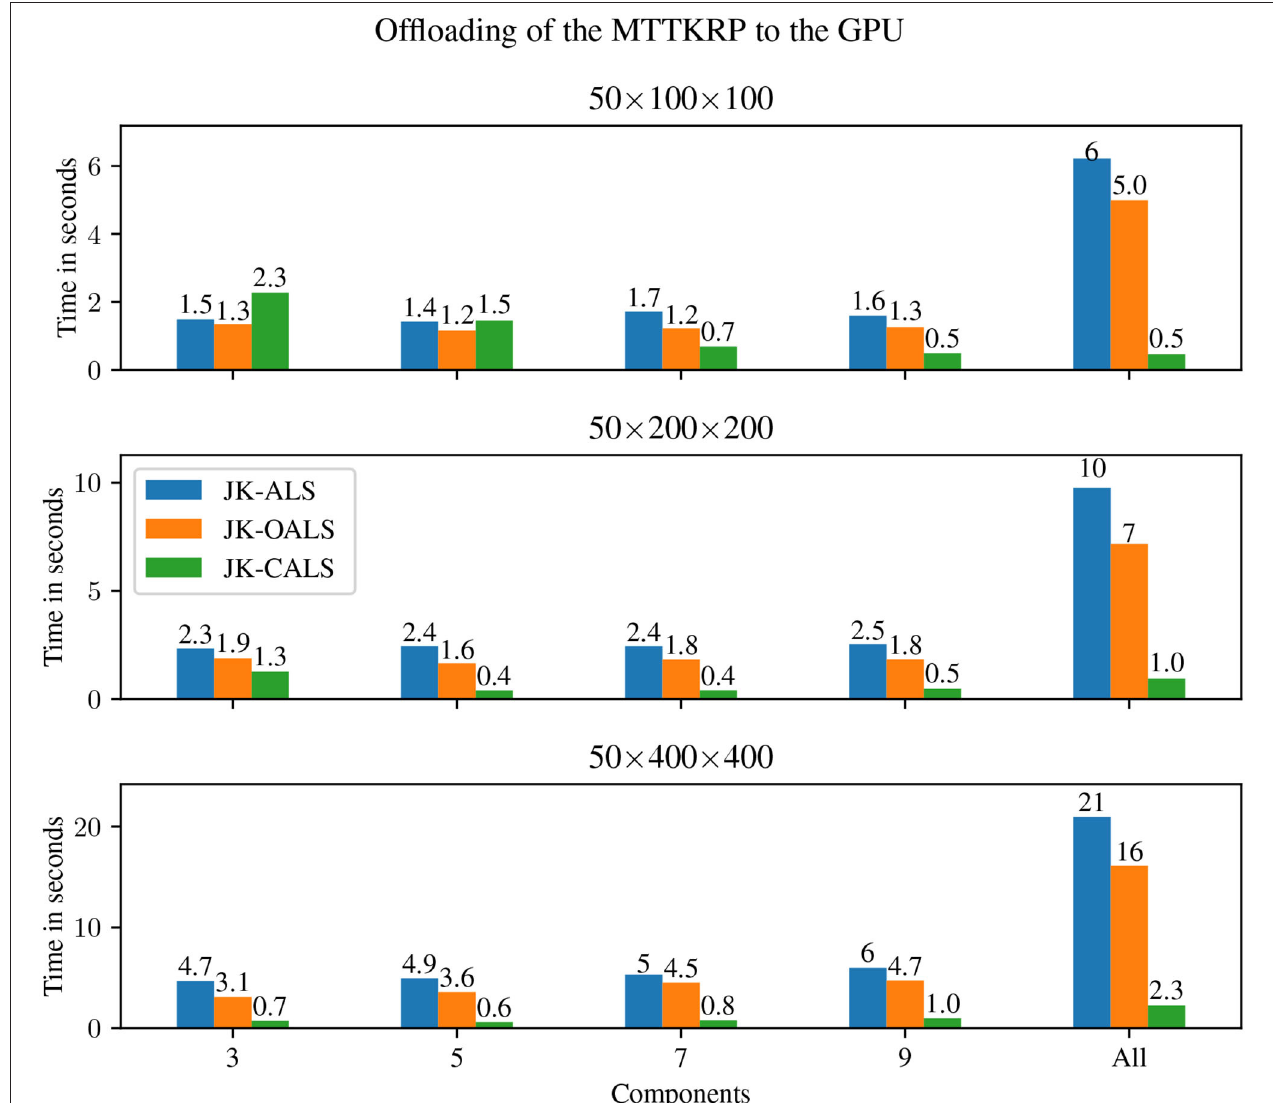
FIGURE 4 | Execution time for GPU + multi-threaded (GPU + 24 threads) jackknife resampling applied to three different tensors (small, medium, and large in the top, middle, and bottom panels, respectively), and different number of components (from left to right: R ∈ { 3,5,7,9 } , and “All”, which represents doing jackknife to all four models